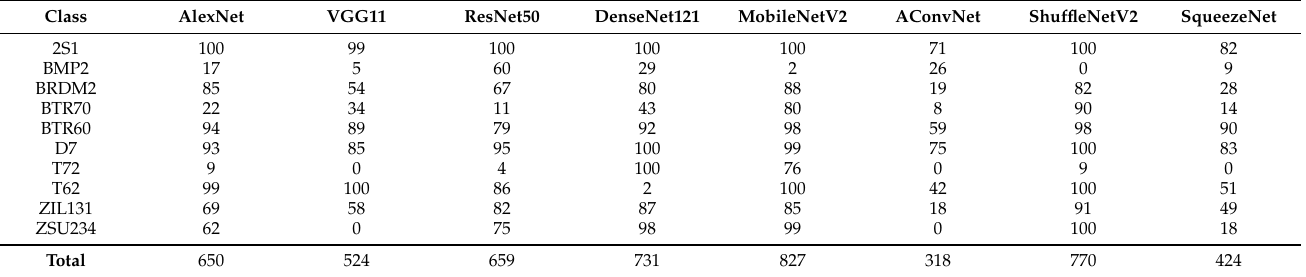
Table A6. Detailed fooling ratio (%) on each class. The attack is GD-UAP with VGG11 as substitute